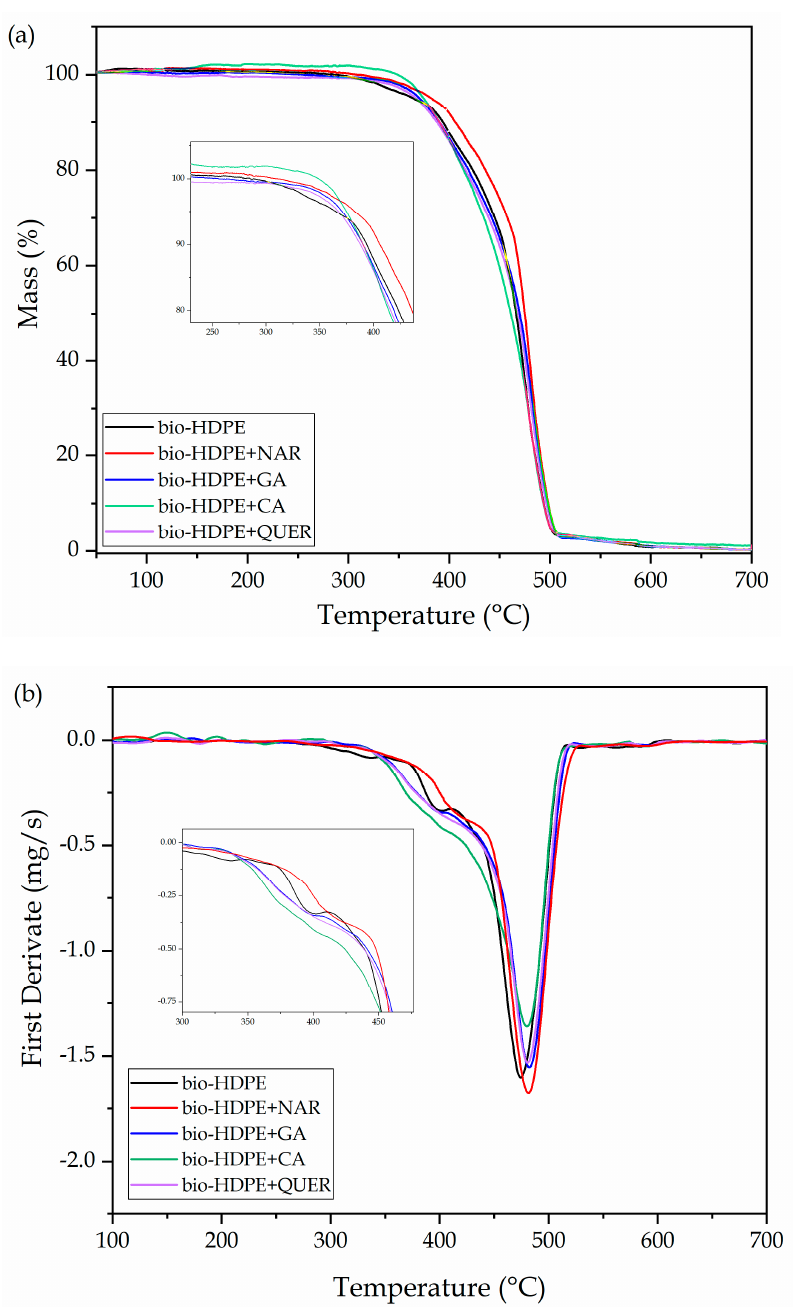
Figure 9. ( a ) Thermogravimetric analysis (TGA) and ( b ) first derivative (DTG) curves of the thermo-compressed bio-based high-density polyethylene (bio-HDPE) films containing naringin (NAR), gallic acid (GA), caffeic acid (CA), and quercetin (QUER).